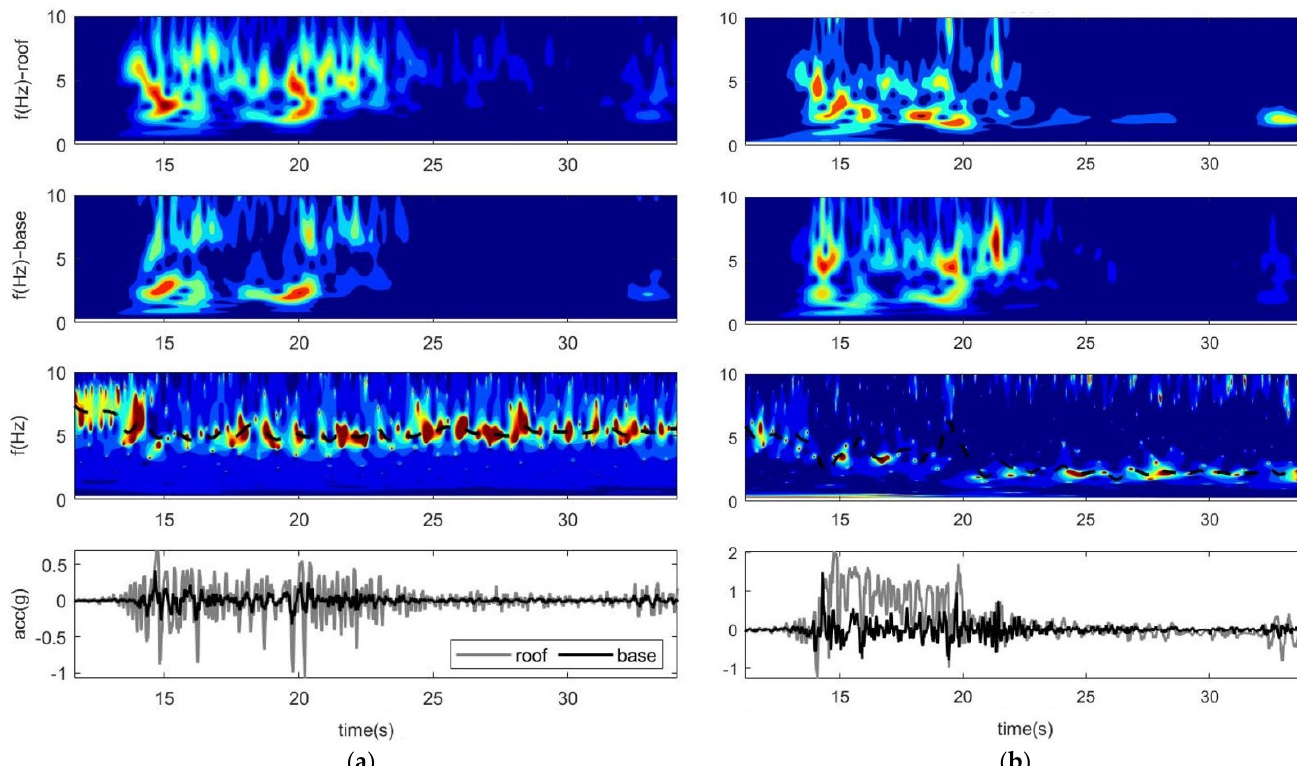
Figure 14. Processing the ground motion data with the approach of ST amplification, consider- ing ( a ) Test 6 and ( b ) Test 9. Dark red indicates high intensity response, dark blue indicates low intensity response.